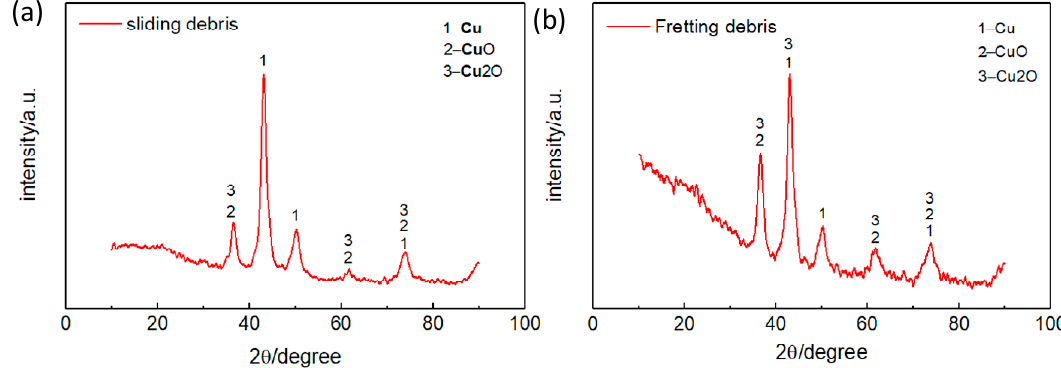
Figure 10. XRD pattern of: ( a ) fretting debris; ( b ) sliding debris.